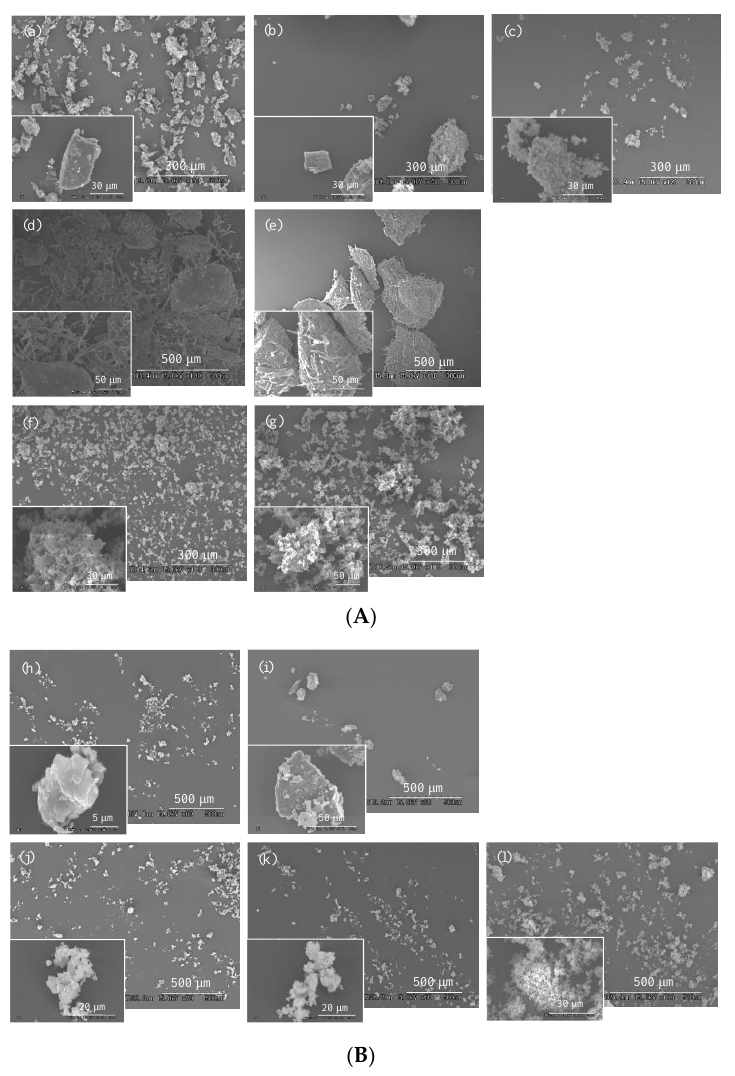
Figure 5. ( A ) SEM micrographs of: ( a ) γ -CD; ( b ) CD-MOF-1; ( c ) EVP (CD-MOF-1); ( d ) ASCP intact; ( e ) PM (ASCP/CD-MOF-1 = 1/2); ( f ) EVP (ASCP/CD-MOF-1 = 1/1); ( g ) EVP (ASCP/CD-MOF-1 = 1/2). ( B ) SEM micrographs of: ( h ) ASCDP intact; ( i ) PM (ASCDP/CD-MOF-1 = 1/4); ( j ) EVP (ASCDP/CD-MOF-1 = 1/1); ( k ) EVP (ASCDP/CD-MOF-1 = 1/2); ( l ) EVP (ASCDP/CD-MOF-1 = 1/4).